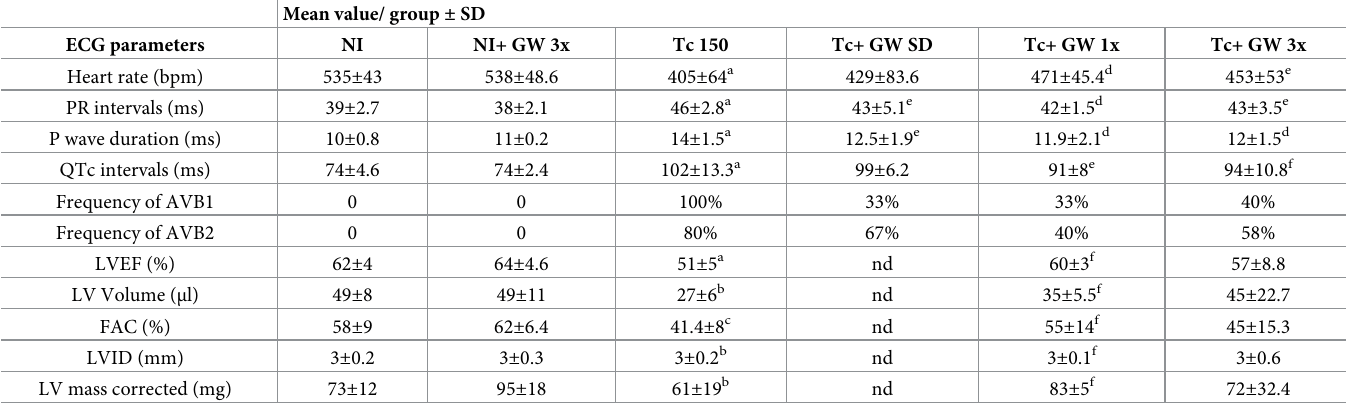
Table 1. ECG and ECHO